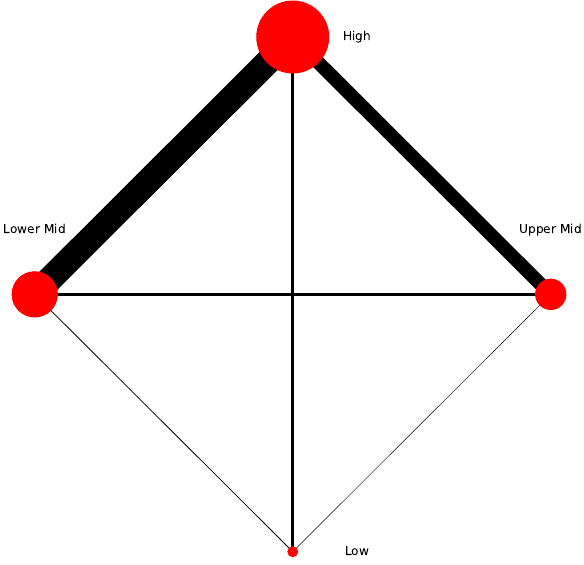
Figure 9. Vertices are weighted to show the relative difference in the number of papers published which include at least one author working in a nation from a given income classification. Edges are weighted to show the relative difference in the number of papers including an international collaboration which includes nations from different income